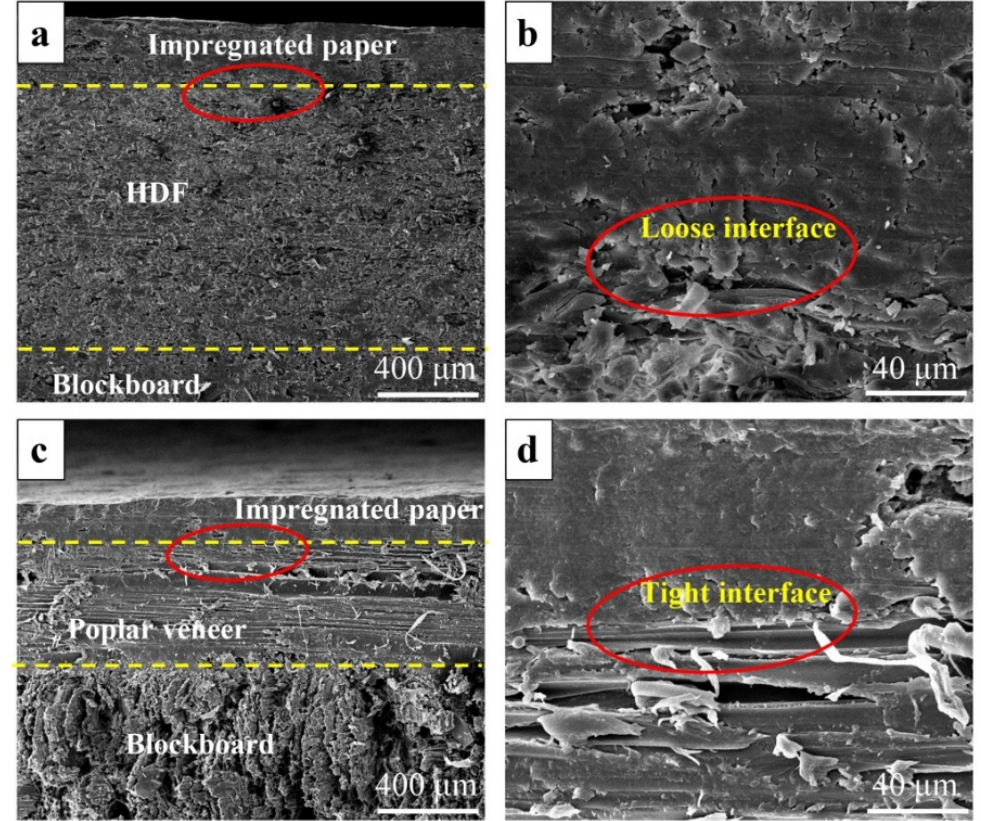
Figure 5. Interface morphology between impregnated paper and different equilibrium layers: ( a ) interface between impregnated paper and HDF (100×); ( b ) interface between impregnated paper and HDF (1000×); ( c ) interface between impregnated paper and poplar veneer (100×); and ( d ) interface between impregnated paper and poplar veneer (1000×).